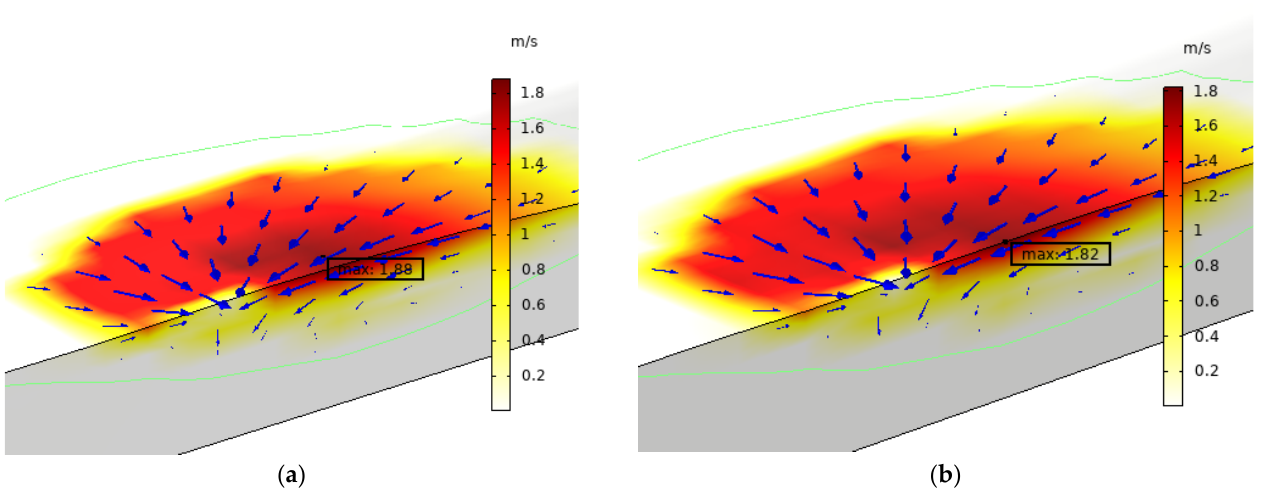
Figure 10. Simulated flow field with depicted directions and velocity magnitude (in m/s) in the molten pool calculated at ( a ) B z = 0 T and ( b ) B z = 10 T under the condition of the permanent magnetic field. The green line marks the liquid–solid interface where the temperature equals the melting temperature. The vector length is proportional to logarithm of the velocity magnitude log (|𝑣|) .